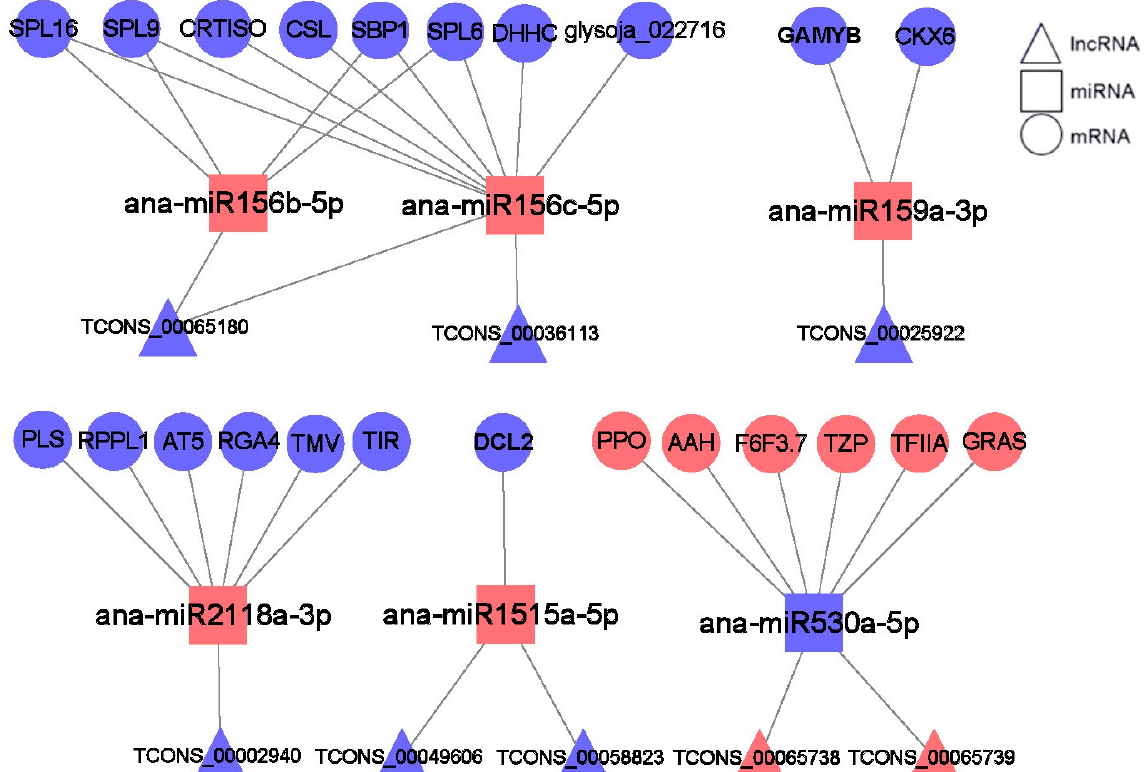
Figure 9. lncRNA–miRNA–mRNA networks involved in the cold stress response in A. nanus . lncRNAs are represented by triangles, miRNAs by squares, and mRNAs by circles. Red represents up-regulated expression pattern and blue represents down-regulated pattern.